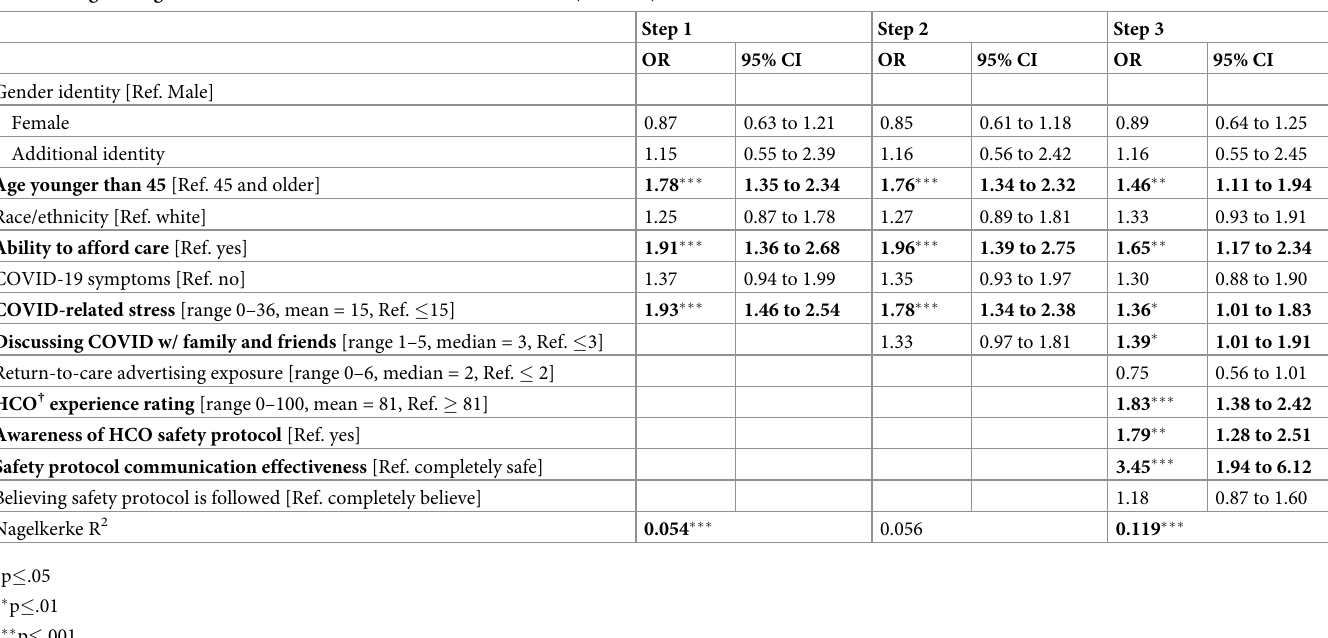
Table 3. Logistic regression for factors associated with care avoidance (n =